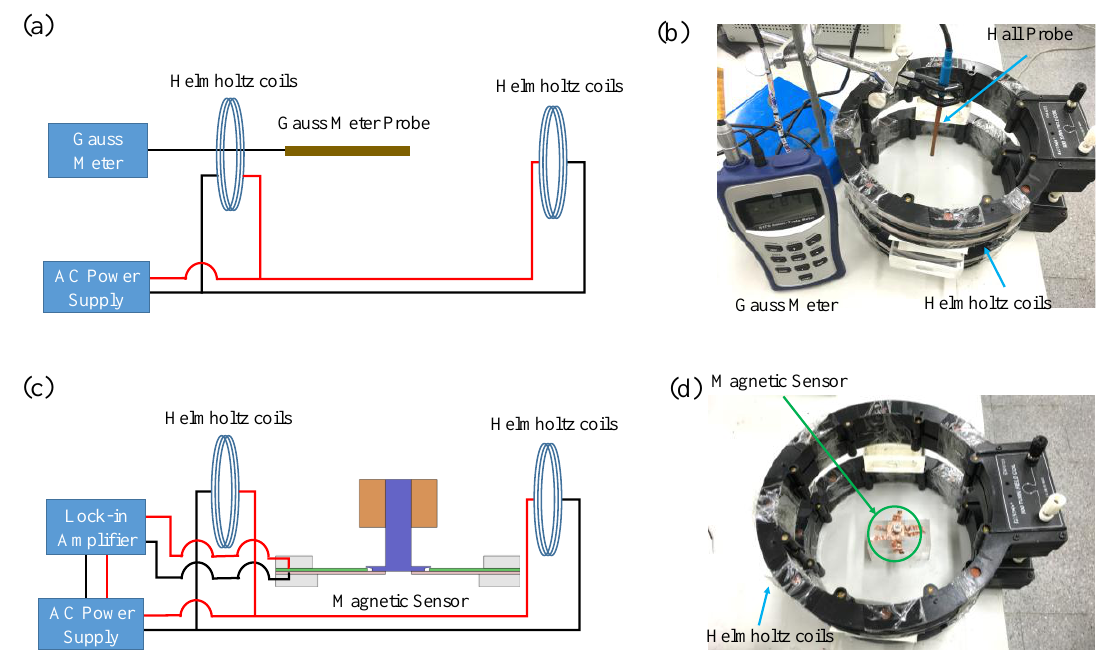
Figure 3. Testing setup of the quantitative test. ( a ) Illustration and (b) photograph of the Hall probe placed in the central area of the coils. ( c ) Illustration and ( d ) photograph of the AC magnetic sensor placed in the central area of the coils.